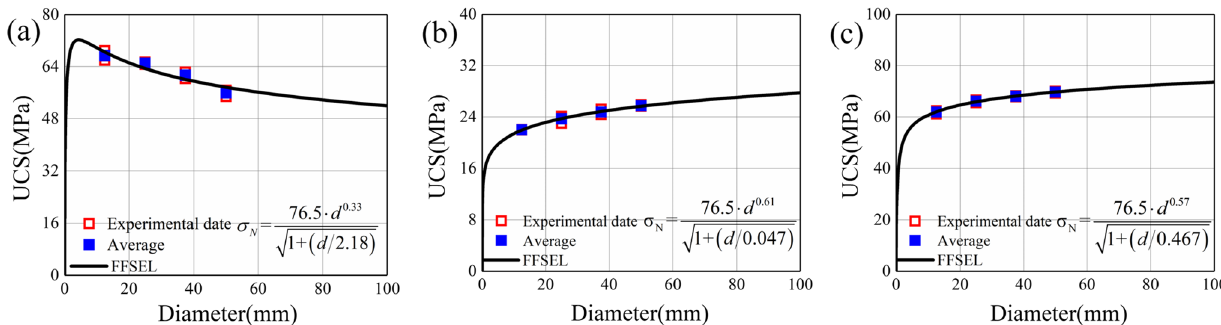
Fig. 10 FFSEL prediction results using the UCS data of the printed rock models. a Fractured model; b Porous model; c Amplified porous